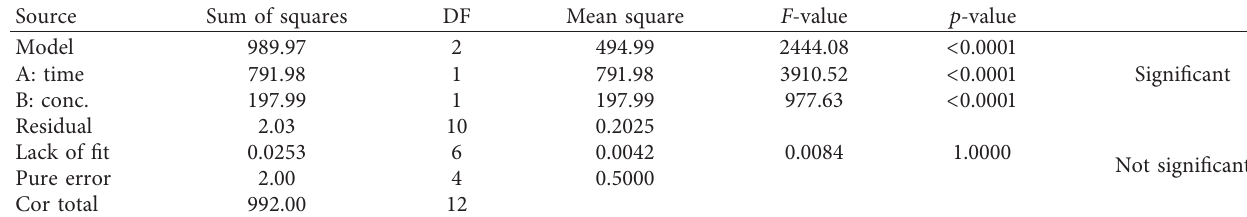
Figure 2: Correlation between actual value and predicted value of (a) water and (b) ethanol extraction yield. Table 3: Analysis of variance (ANOVA) of the water extraction yield.